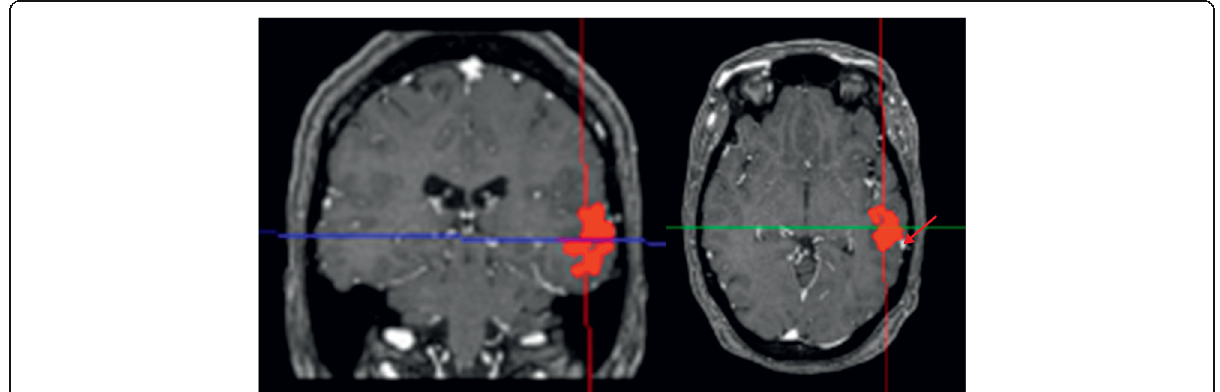
Fig. 3 Recordings during non-convulsive status epilepticus delineated a temporal lobe origin in a patient with unremarkable magnetic source imaging (MRI)